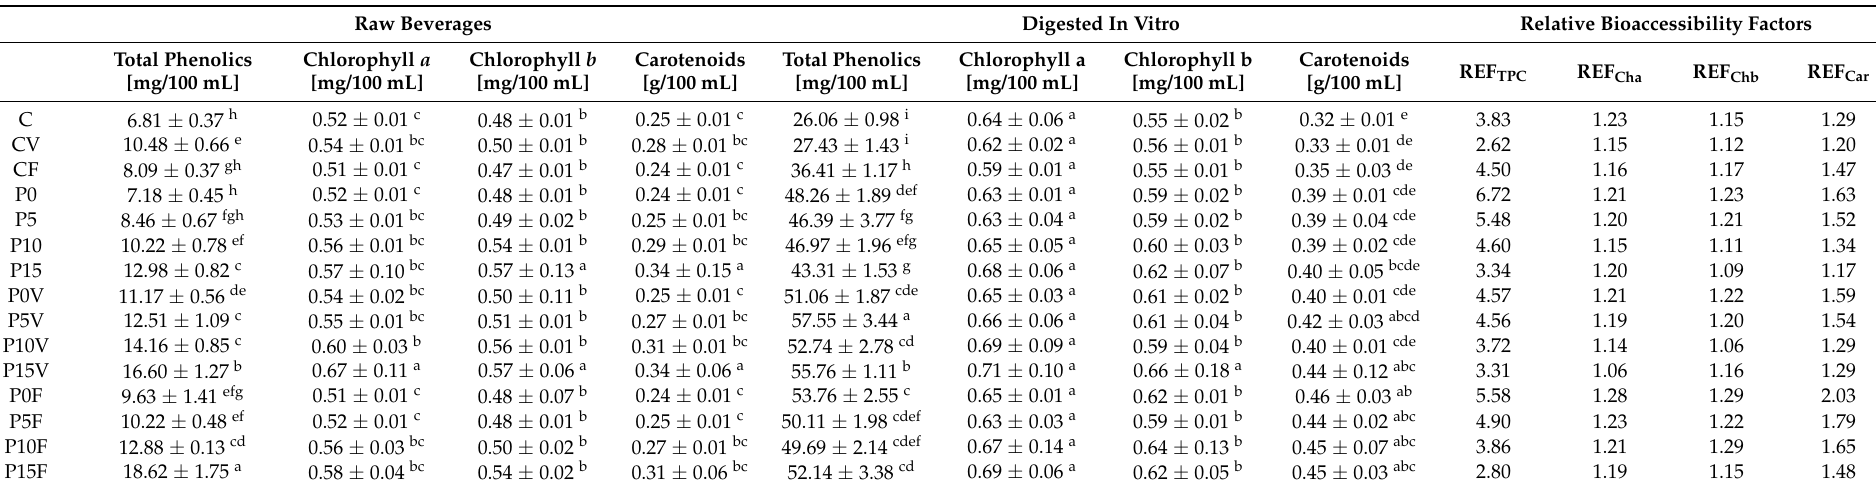
Table 1. Content of total phenolics, carotenoids and chlorophylls in rehydrated and digested